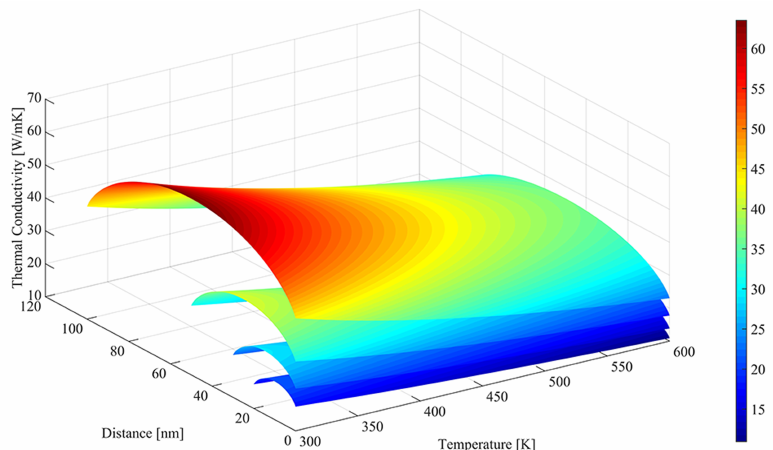
Figure 2. Depth and temperature dependence of the thermal conductivity of the ultra-thin body fully depleted (FD) silicon-on-insulator (SOI) metal-oxide-semiconductor field-effect transistor (MOSFET) for different silicon film thicknesses of 20 nm, 40 nm, 50 nm and 100